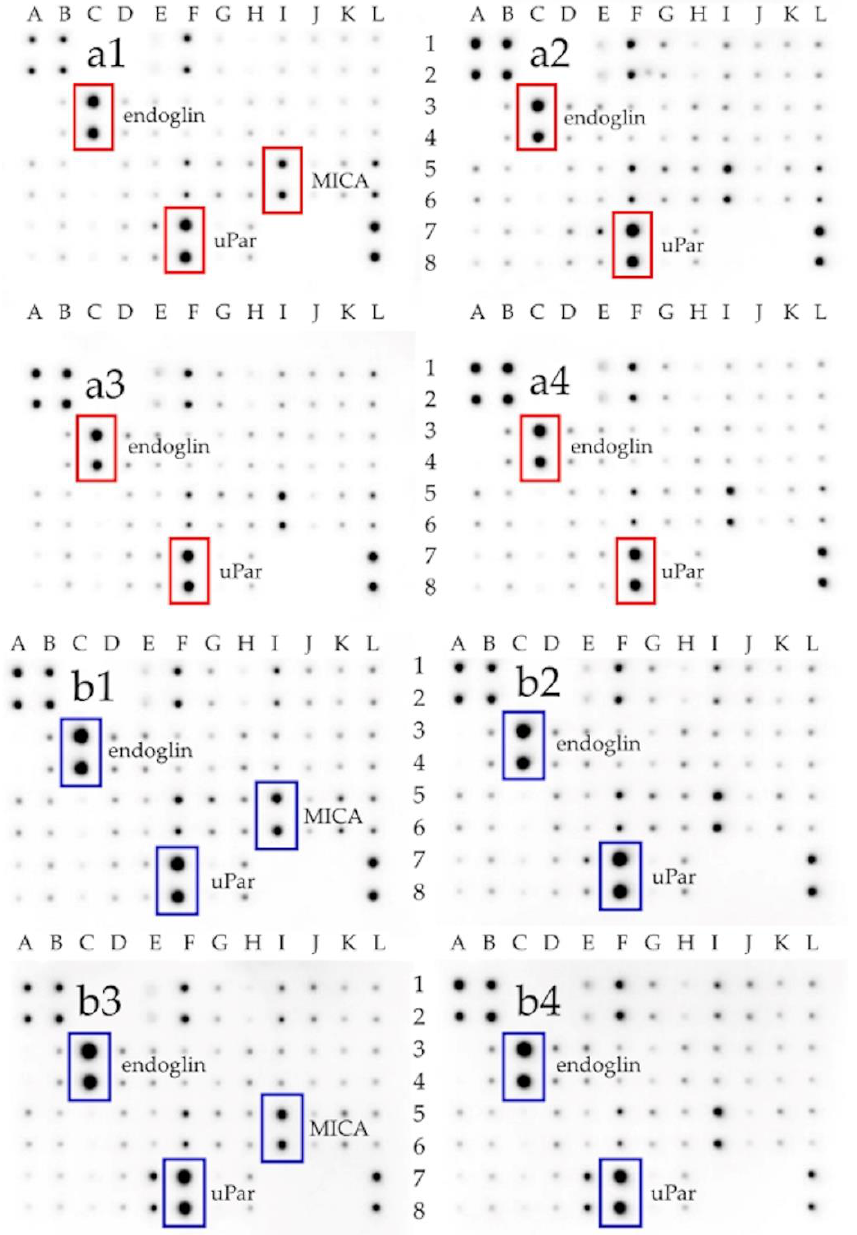
Figure 5. Antibody array analysis of human cell membrane receptor (original drafts) in U87 glioma cells ( a1 – a4 ) and Hs5 fibroblast cells ( b1 – b4 ), with or without 24 h treatment (C: control, a1 , b1 ), with graphene flakes (GN/ExF: a2 , b2 ) and two types of reduced graphene oxides (rGO/ATS: a3 , b3 ; rGO/TUD: a4 , b4 ). The full array map and uncropped images are available in the supplement material. Results were normalized and compared to a dots control sample. The dots with the location (C3, C4) indicate the expression of endoglin (CD105), (F7, F8) indicate uPar (CD87), and (I5, I6) indicate MICA. Abbreviations : rGO, reduced graphene oxide; GN, graphene; C, control group (untreated group); ExF, exfoliation; Term, thermal; ATS, ammonium thiosulphate; TUD, thiourea dioxide; CD105, endoglin; uPar, urokinase plasminogen activator surface receptor; MICA, major histocompatibility complex class I chain-related protein A.